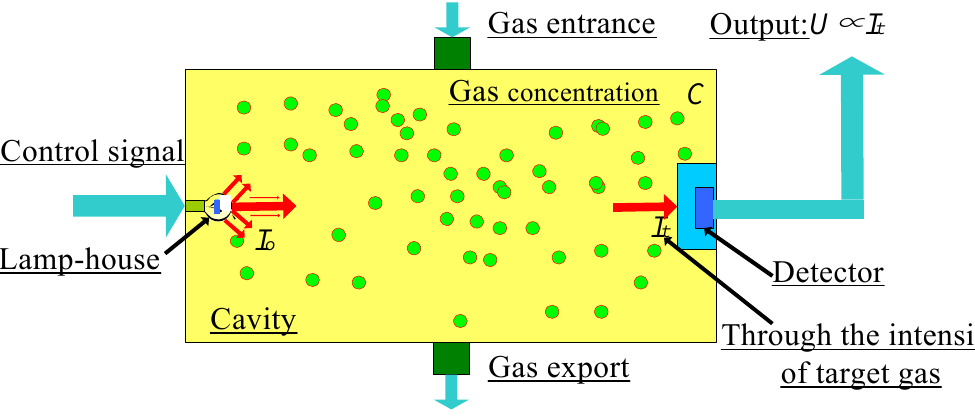
Figure 1. Gas detection model based on IR absorption